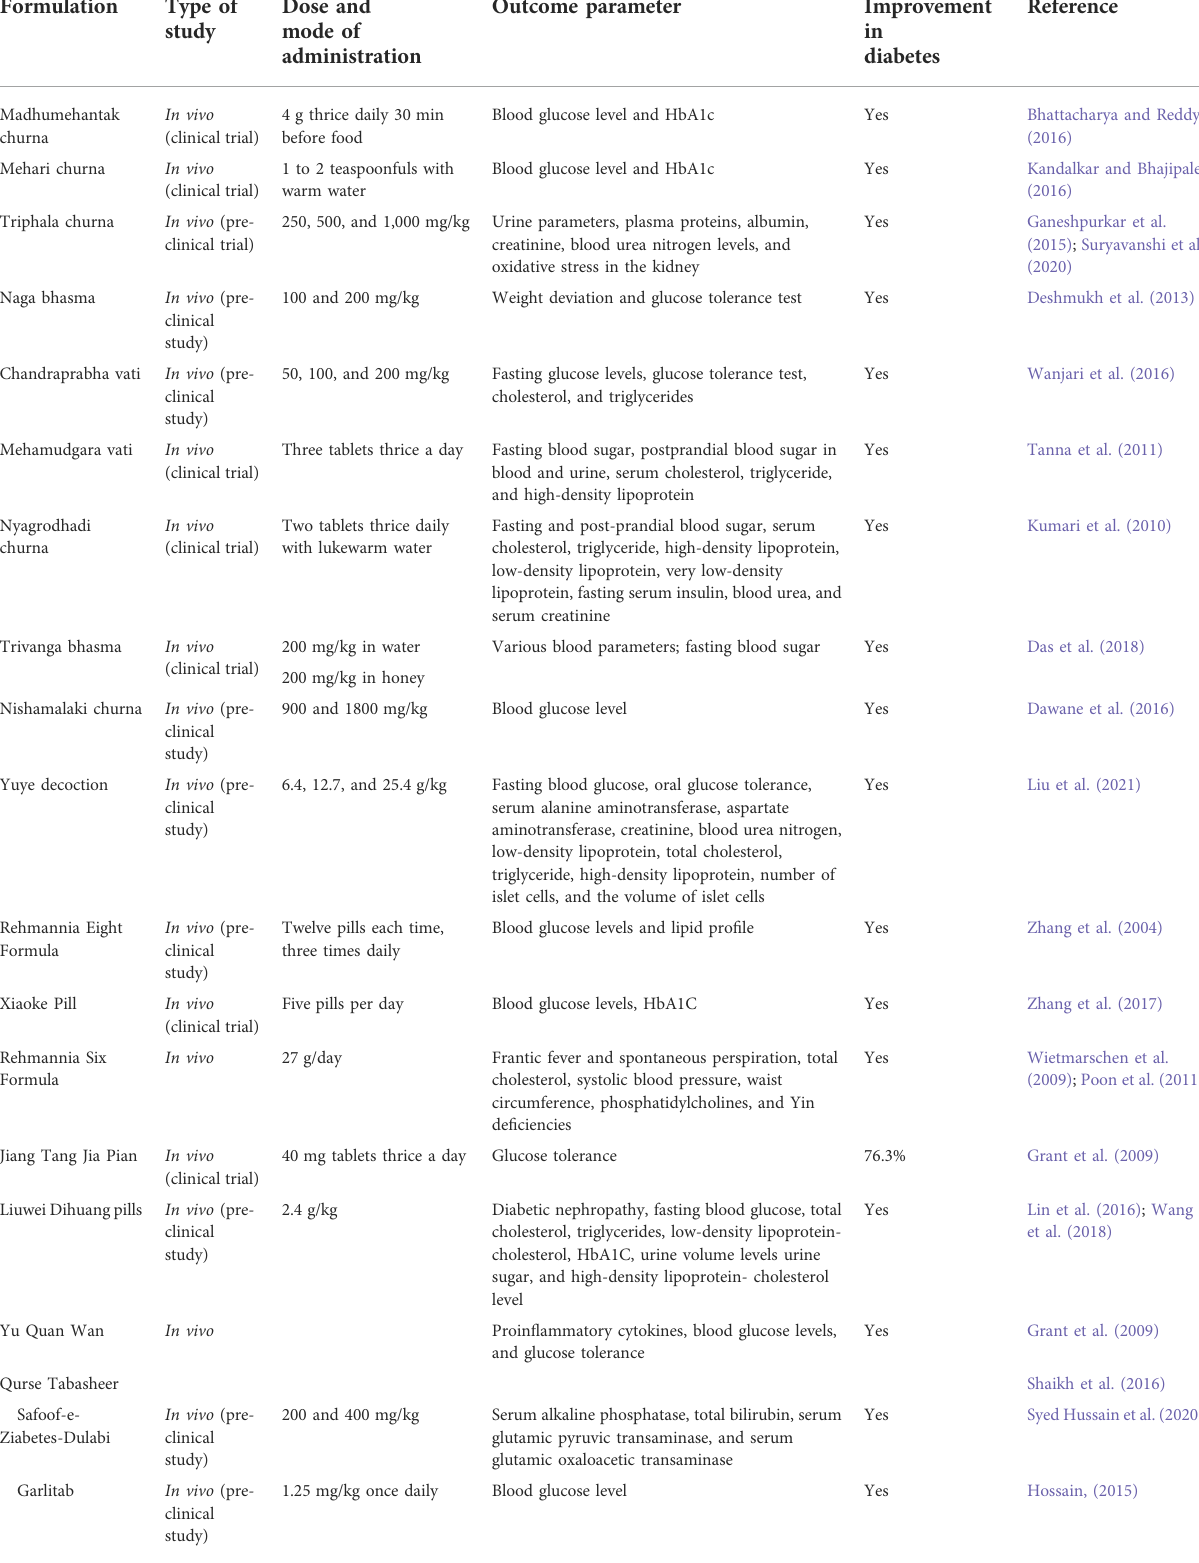
TABLE 1 Summary of the various formulations of Ayurveda, Chinese, and Unani medicine systems used for the management of diabetes.